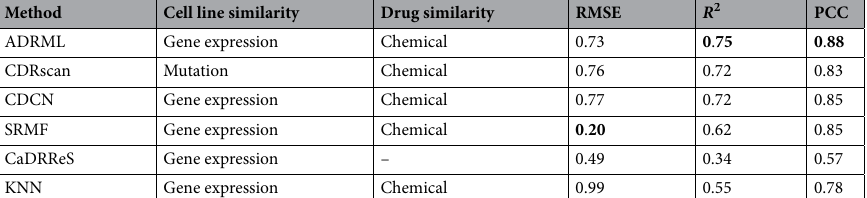
Table 4. Comparison of methods’ performance on the GDSC dataset. The methods were evaluated by averaging over 30 repetitions of using fivefold cross-validation on cell line-drug pair. The best result of each criterion is shown in